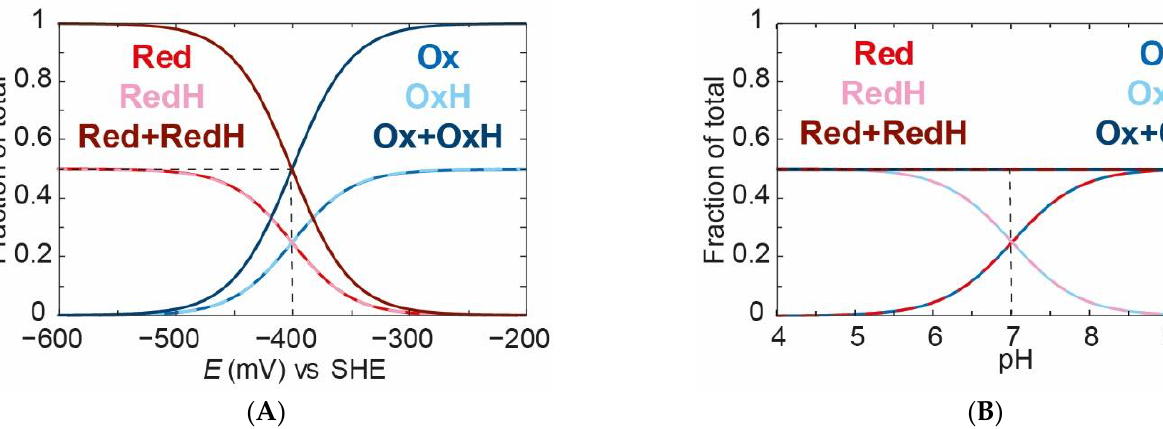
Figure 5. Variation of the fraction (out of 1) of deprotonated oxidised ( Ox , medium blue), deprotonated reduced ( Red , medium red), protonated oxidised ( OxH , light blue dashed), and protonated reduced ( RedH , light Red dashed) species as a function of the applied potential ( A ) or pH ( B ). The sum of Ox and OxH (dark blue) and the sum of Red and RedH (dark red) are also plotted. The curves were obtained using Equations (7), (11), (12), and (15), with 𝐸 1𝑂 = −400 mV, K a, 1 = K a, 2 = 10 −7 ( pK a, 1 = pK a, 2 = 7), a pH of 7 ( A ) or an applied potential of −400 mV vs. SHE ( B ). These values are arbitrary, but were chosen here to give conditions where no PCET can be observed but conserve the redox midpoint potential of −400 mV and apparent pK a value of 7. 𝐸 2𝑂 was calculated using Equation (21) to be −400 mV, giving an average E O of −400 mV, for a comparison with Figure 2.